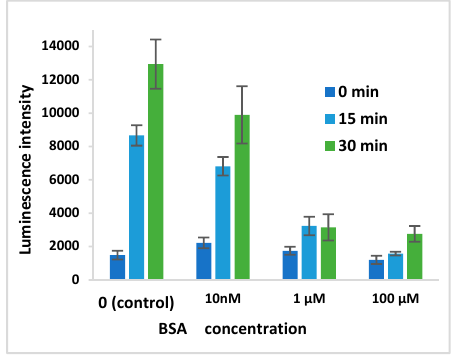
Figure 4. Luminescence from AuNP after coating with BSA.